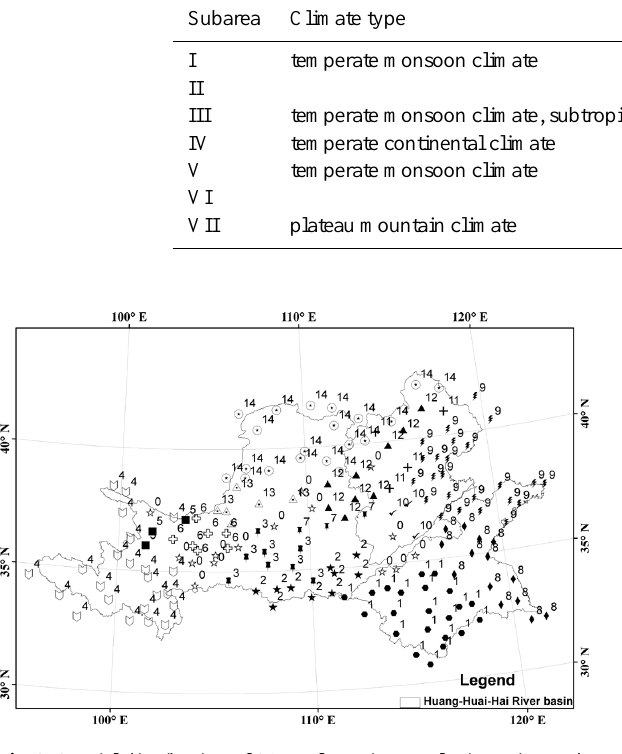
Fig. 2. Spatial distribution of SOM clustering results in various sub- areas.